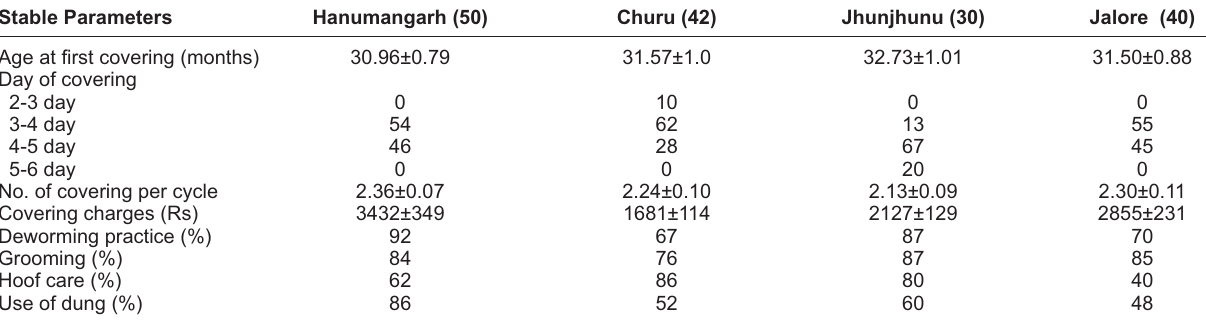
Table-4. Breeding and health management practices for horses in four districts of Rajasthan Stable